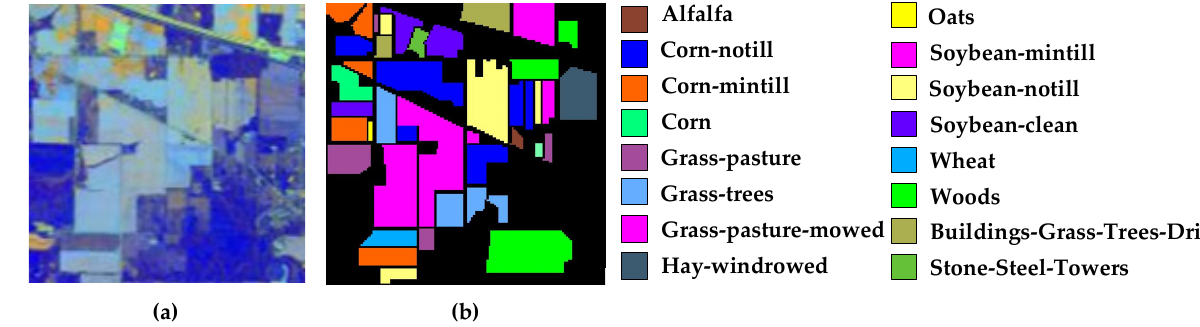
Figure 14. Indian Pines: ( a ) false-color map; ( b ) ground-truth image. Table 1. Number of training, validation, and testing samples for the IP dataset. Figure 15. University of Pavia: ( a ) false-color map; ( b ) ground-truth image. Table 2. Number of training, validation, and testing samples for the UP dataset.